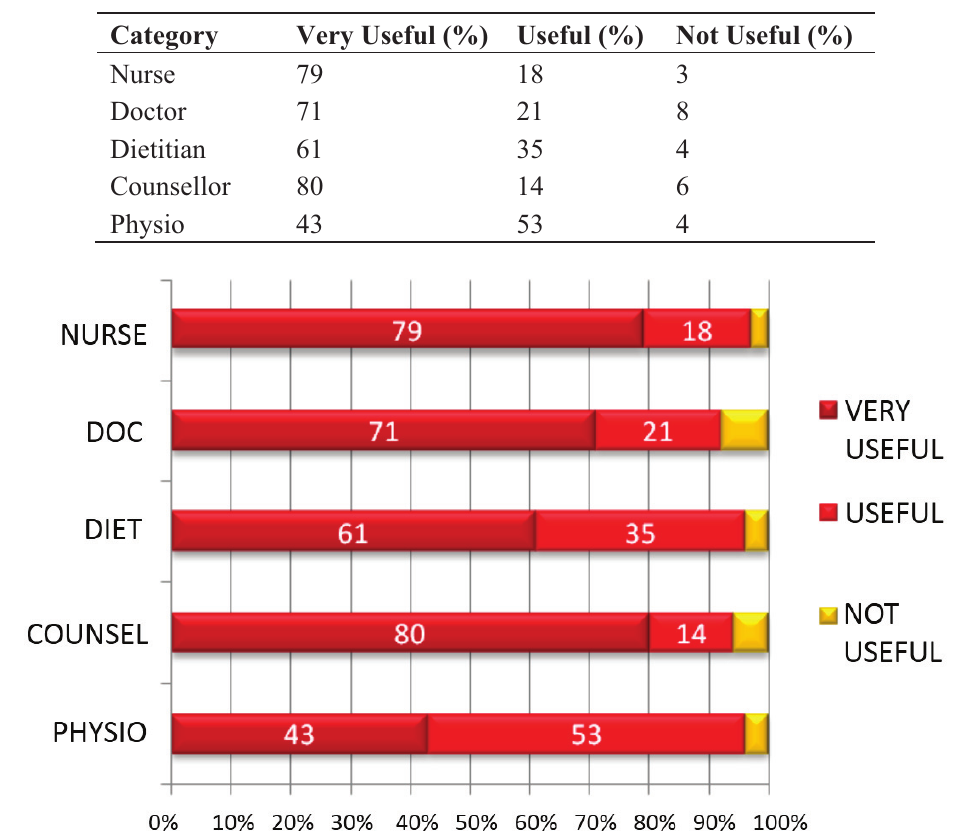
Table 9. Percentage of respondents finding consultations with each healthcare professional useful.